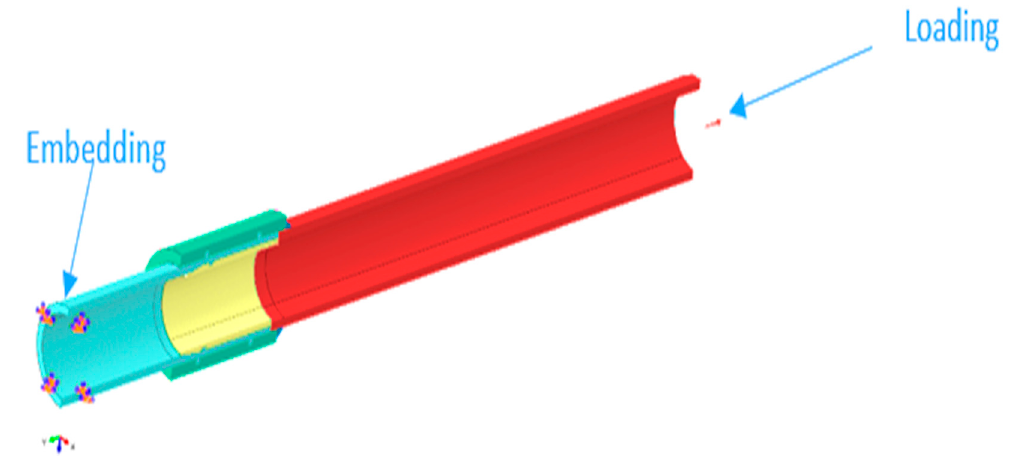
Figure 2. The loading mode and the restrictions applied to the transition fittings subjected to analysis by the finite element method.